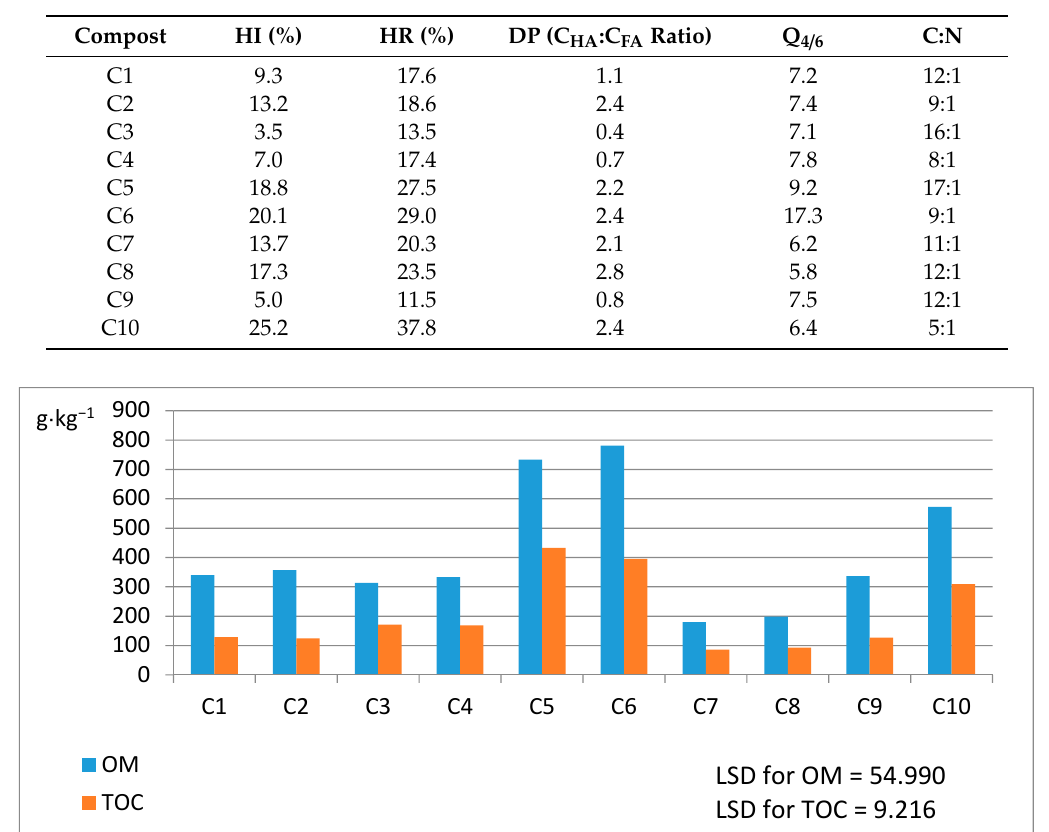
Figure 1. Contents of organic matter and total organic carbon in analysed composts.